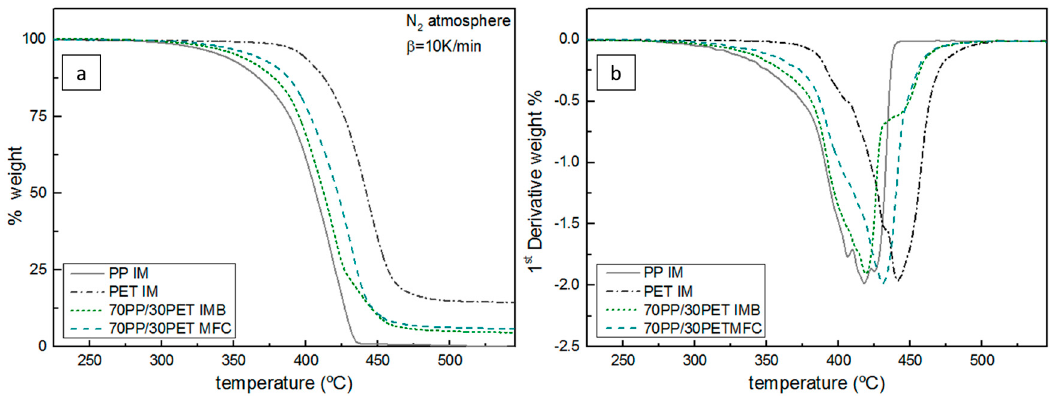
Figure 3. Dynamic ( a ) TG curves and ( b ) dTG of PP IM, PET IM, 70PP/30PET IMB, and 70PP/30PET MFC at 210 °C.